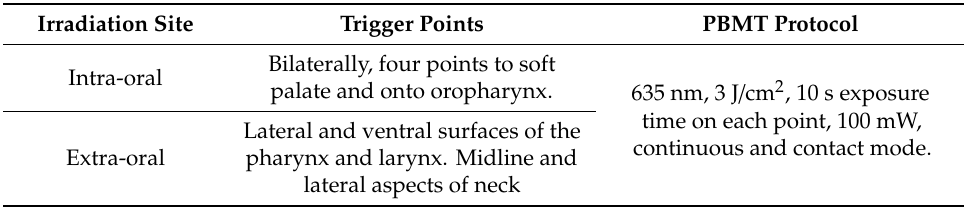
Table 3. Applications and treatment protocols (intra- and extra-oral approaches) of PBMT in dysphagia treatment. Irradiation Site Trigger Points PBMT Protocol Bilaterally, four points to soft Intra-oral palate and onto oropharynx. time on each point, 100